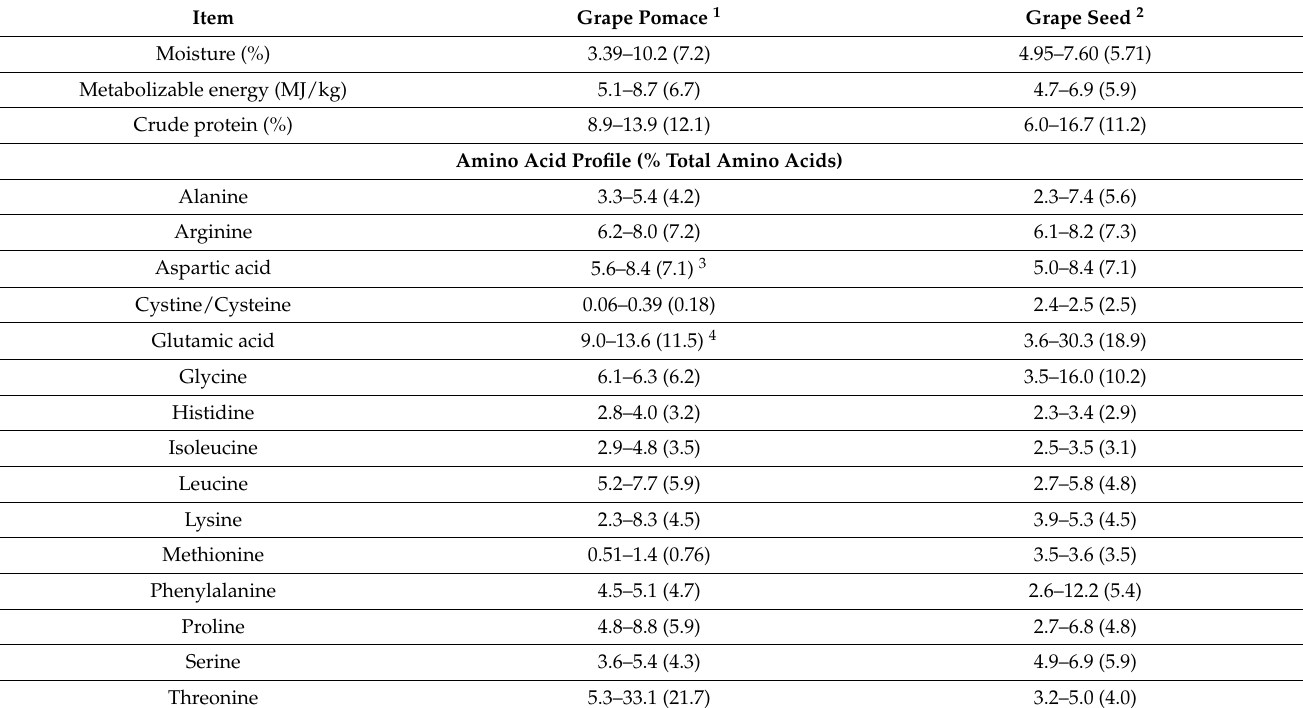
Table 1. Metabolizable energy, protein content, amino acid profile, and carbohydrate content of grape pomace and grape seed (values are expressed on a dry weight basis, w/dw, hyphenated values are